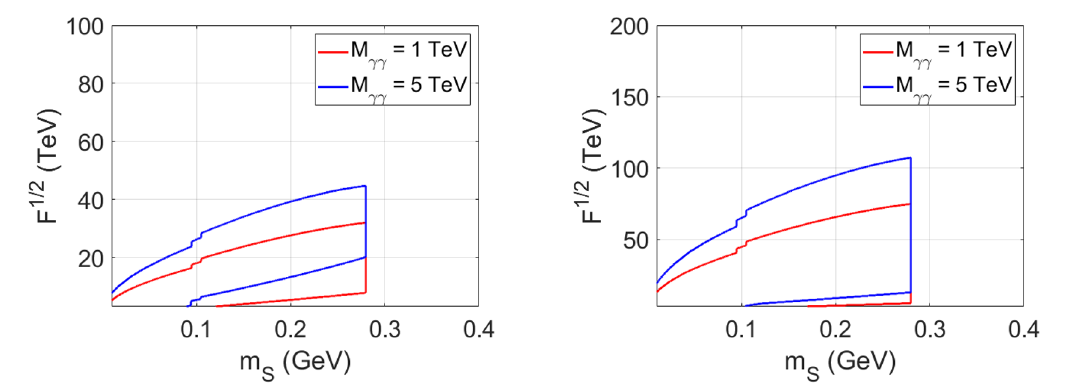
Figure 11 . Sensitivity regions of FASER-I (left panel) and FASER-II (right panel). Sgoldstinos are produced in η -meson decays and decay inside the detector into a couple of photons. A Q = 100 GeV, √ √ M 3 = 3 TeV. In the regions where F < M γγ we set M γγ = F . stino masses are limited by the decay threshold into pions. For a realistic sets of model parameters this production mechanism is promising only for the two photon